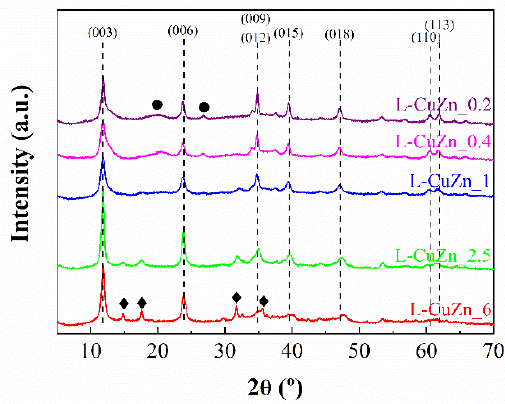
Figure 1. XRD patterns of the layered double CuZnAl hydroxides. (Circles: zinc hydroxycarbonate), (diamonds: copper(II) hydroxide).